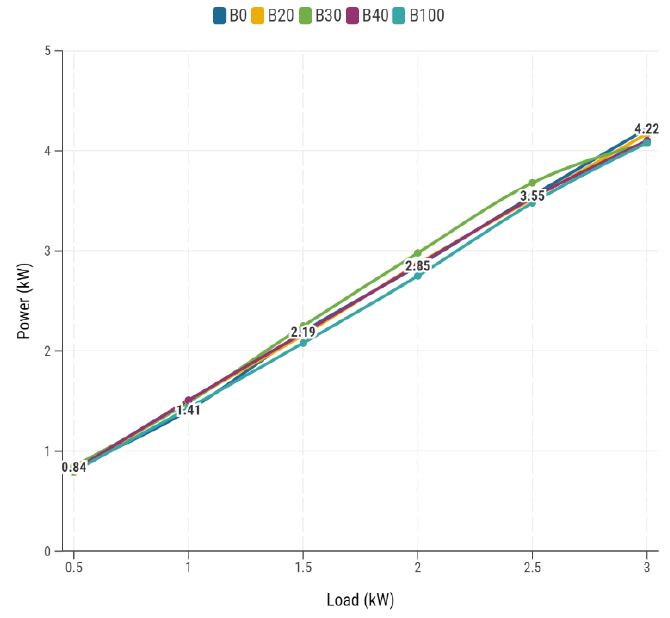
Figure 7. Engine power at different loads.